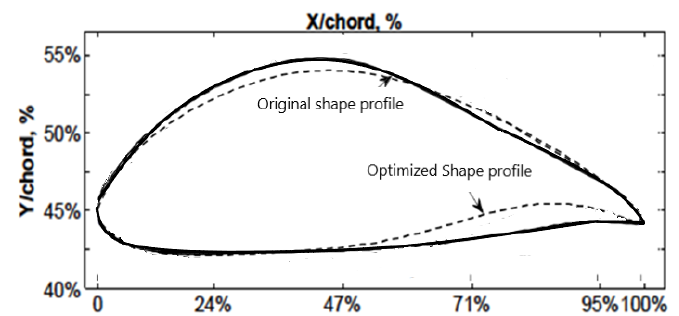
Figure 3. Airfoil shape design before and after optimization process.